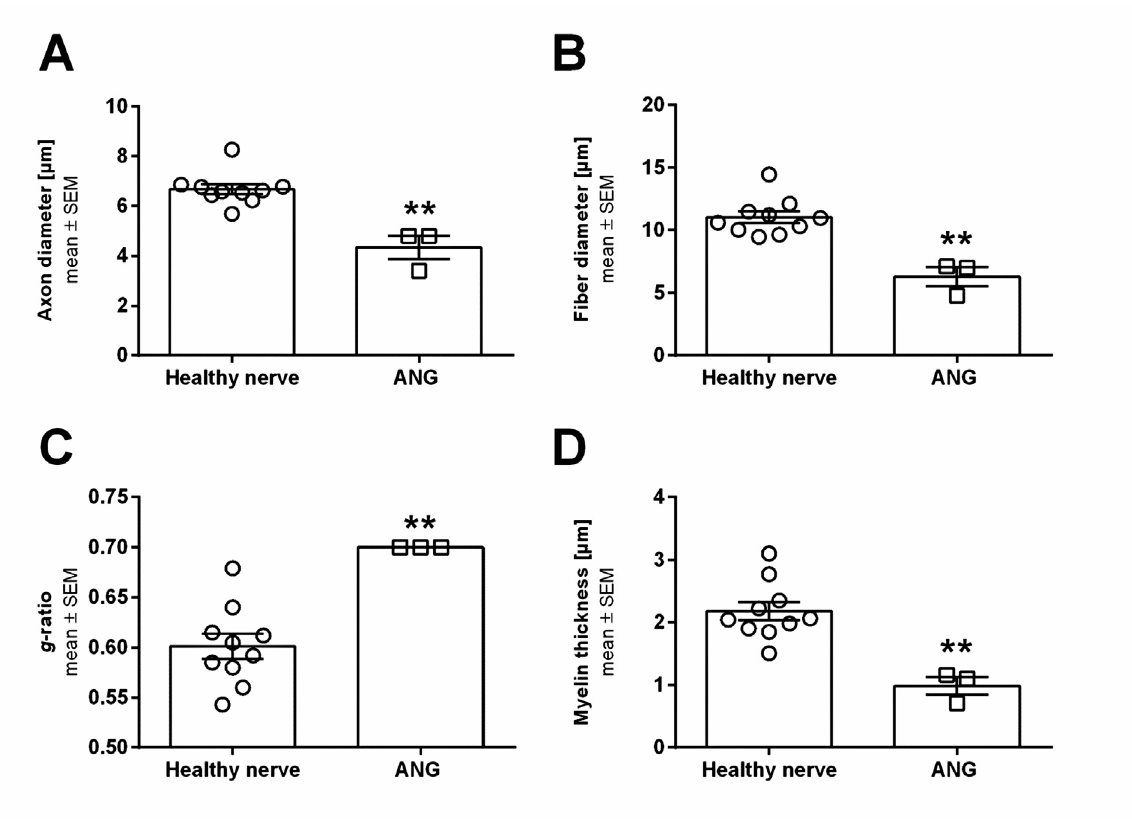
Fig. 5 Scatter plot with bar graphs displaying results from histomorphometrical analyses of distal nerve segments from healthy or autologous nerve graft reconstructed sciatic nerves at 6 months post-surgery. Axon diameters ( A ), fi ber diameters ( B ), g -ratios ( C ), and myelin thicknesses ( D ) are shown. Signi fi cant differences ( p < 0.05) were detected by Mann – Whitney test ( (cid:1)(cid:1) p < 0.01 vs. healthy nerve). Results are presented as mean (cid:4) SEM (healthy nerve: n ¼ 10; ANG: n ¼ 3). ANG, autologous nerve graft; SEM, standard error of